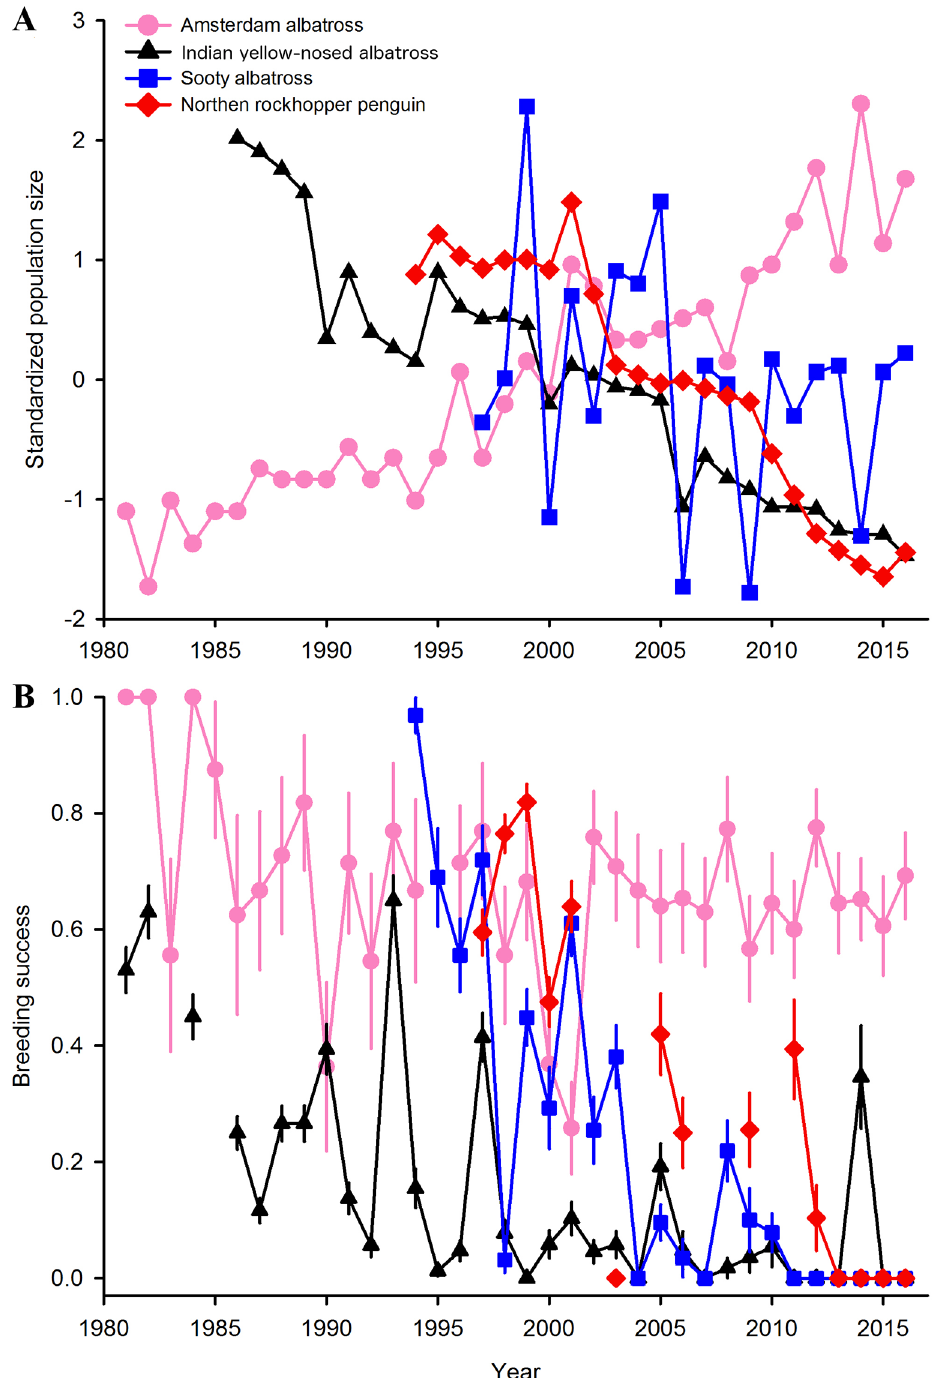
Fig 1. Breeding population trends of four seabird species at Amsterdam Island since 1981. Changes in (a) standardized population sizes and (b) breeding success.